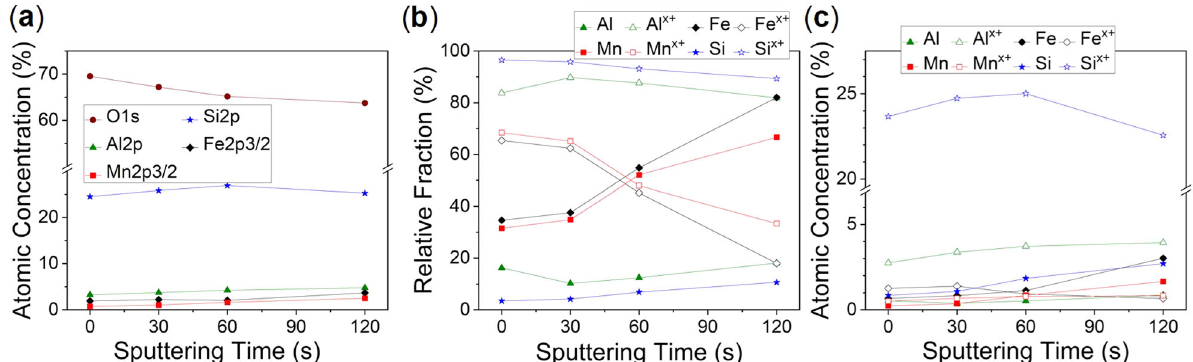
Fig. 7 XPS of the AlFeMnSi surface after potentiostatic conditioning for 10 min at + 400 mV SCE in 0.6 M NaCl. Distribution of elements as a function of sputtering time determined by XPS following potentiostatic conditioning for 10 min at + 400 mV SCE of the AlFeMnSi alloy in 0.6 M NaCl: a atomic concentration, b relative fraction of oxidized element to corresponding unoxidized metal species, and c atomic concentration of oxidized and unoxidized